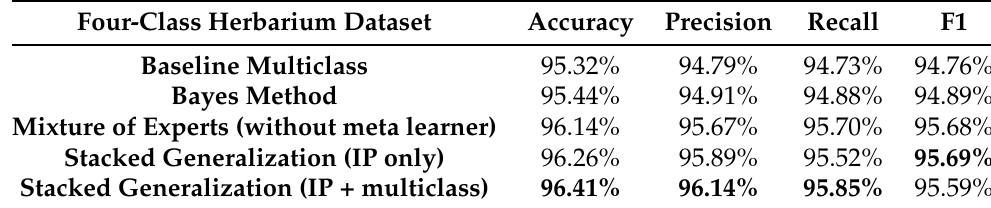
Table 3. Evaluation metrics for the four-class herbarium dataset. The highest accuracy metrics are highlighted using